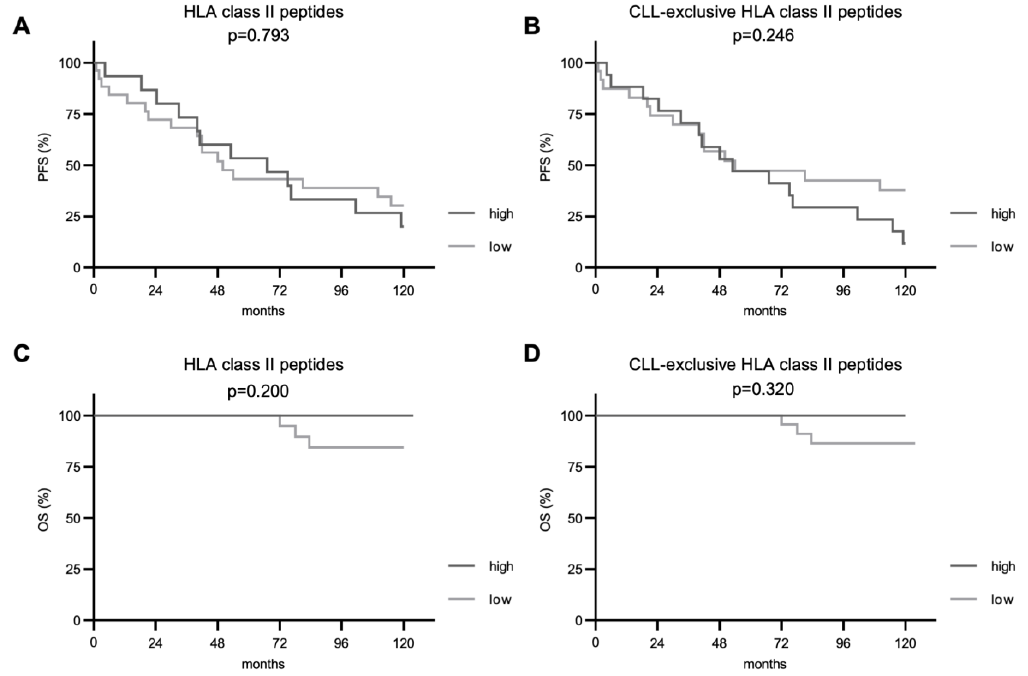
Figure 4. Impact of total and CLL-exclusive HLA class II peptide presentation on clinical outcome. Impact of total and CLL-exclusive HLA class II peptide presentation on PFS ( A , B ) and OS ( C , D ). Kaplan – Meier analysis, log-rank test. Abbreviations: p , p -value.